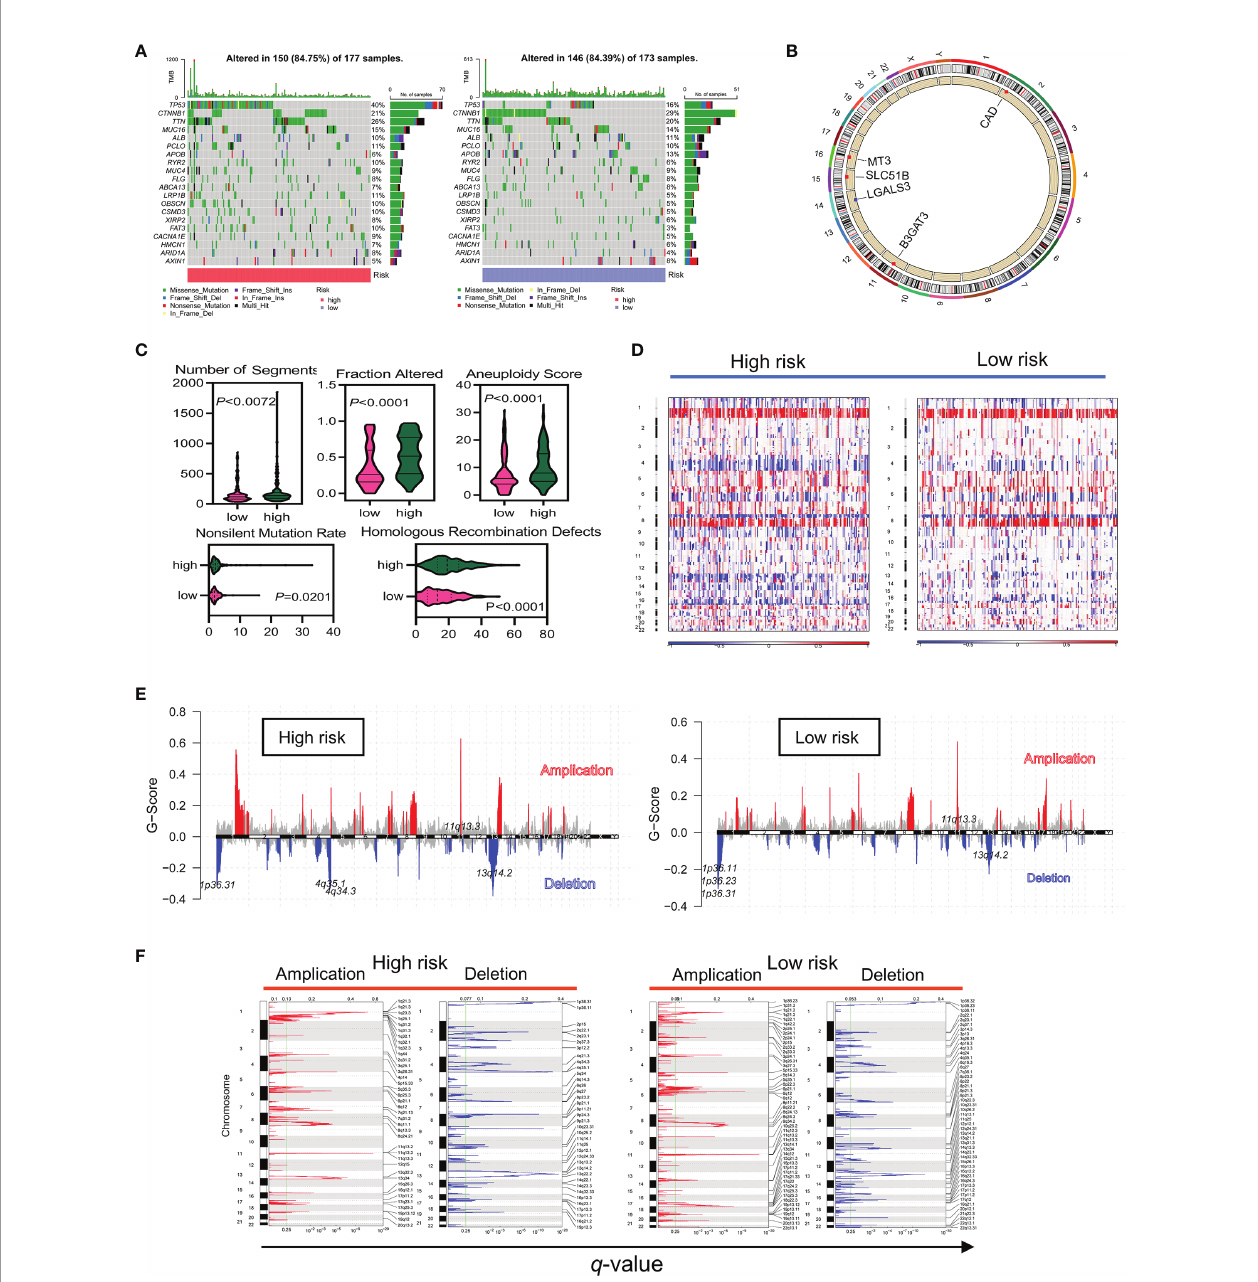
FIGURE 6 | The high-risk group had a higher frequency of somatic mutations and CNVs in TCGA data. (A) Differences in somatic mutation frequency in the high- and low-risk groups. (B) Five gene copy loss and copy ampli fi cation proportion distributions in the genome. (C) Scores of the fi ve distinct mutation indices (number of segments, fraction altered, aneuploidy score, nonslinet mutation rate, and homologous recombination defects) in the low- and high-risk groups. (D – F) CNVs in different risk subgroups. Red and blue represent the two types of CNVs, ampli fi cation and deletion,